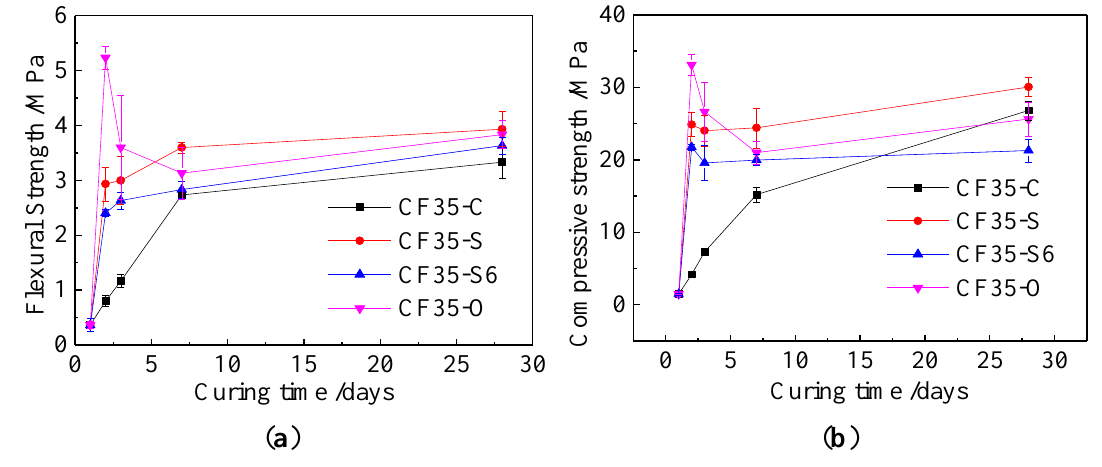
Figure 1. Effect of curing conditions on strength of Class C fly ash geopolymer at W/F0.35.